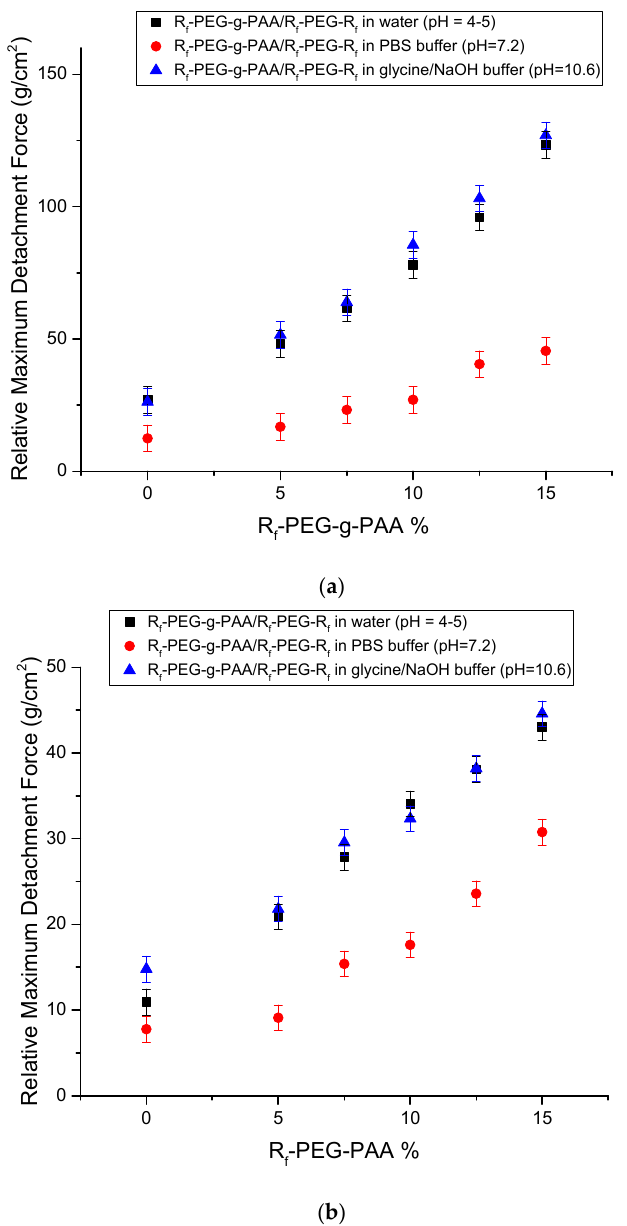
Figure 1. ( a ) Comparison of relative maximum detachment stresses (MDSs) of the interactions between the R f -PEG-g-PAA/R f -PEG-R f samples and the mucus samples prepared in different buffers (shown in the inset). ( b ) Comparison of the relative MDSs of the interactions between the R f -PEG-g-PAA/R f -PEG-R f samples prepared in different buffers (shown in the inset) and the pig small intestine surface.